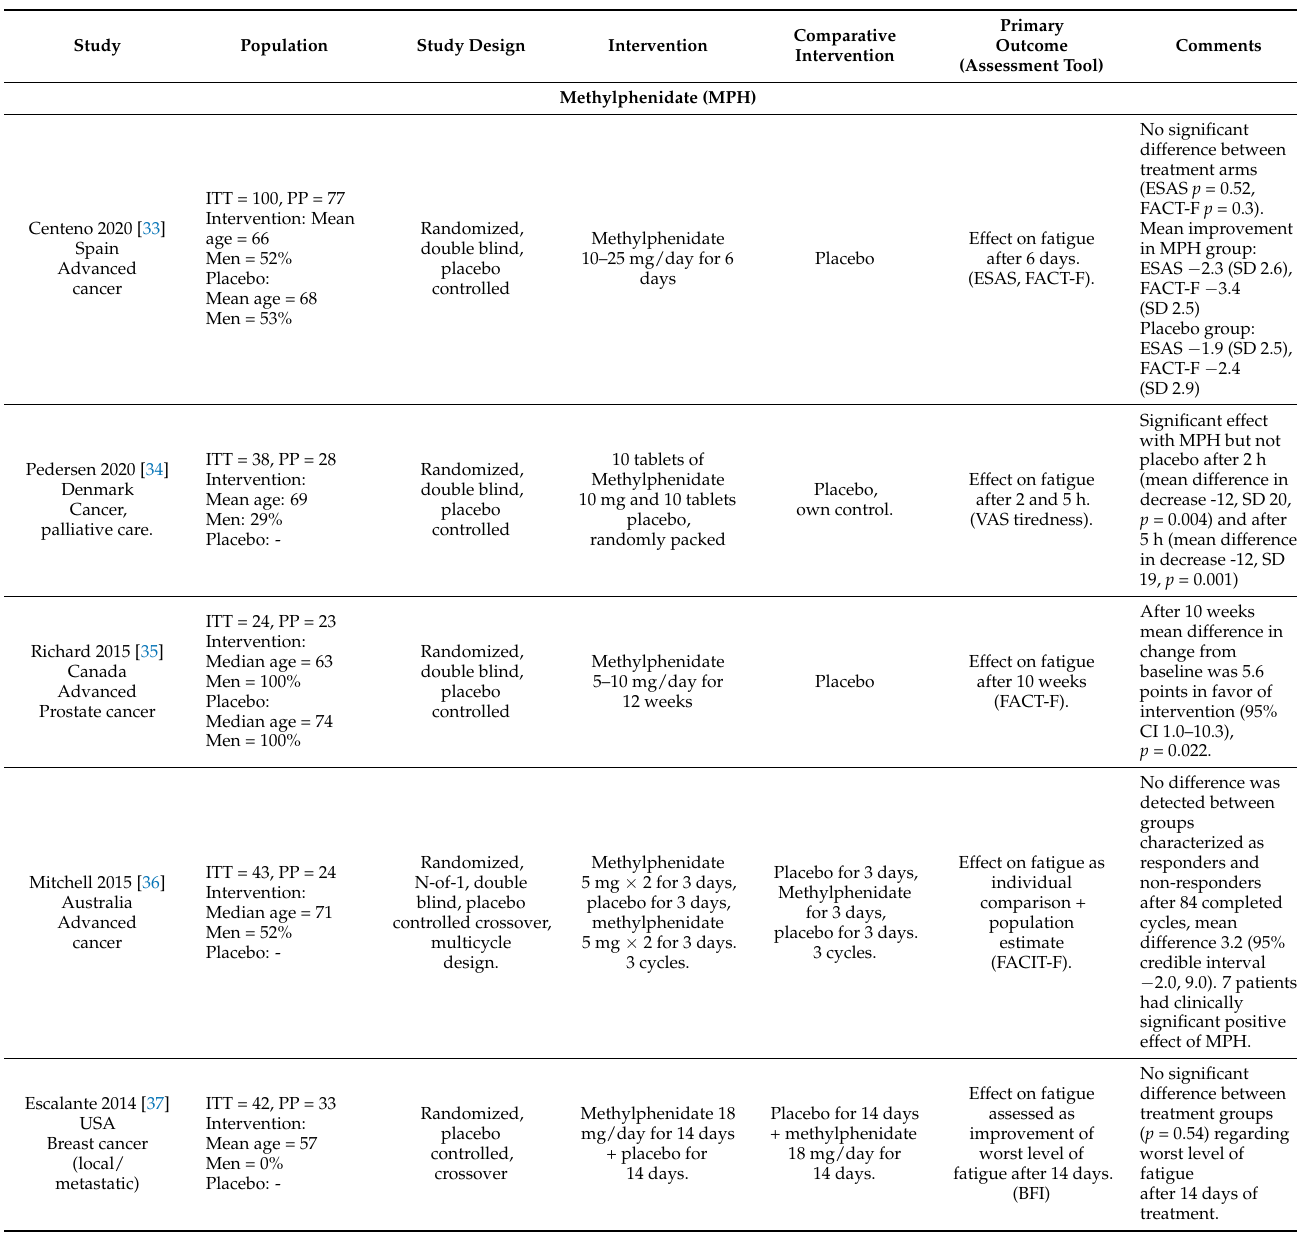
Primary Outcome (Assessment Tool)